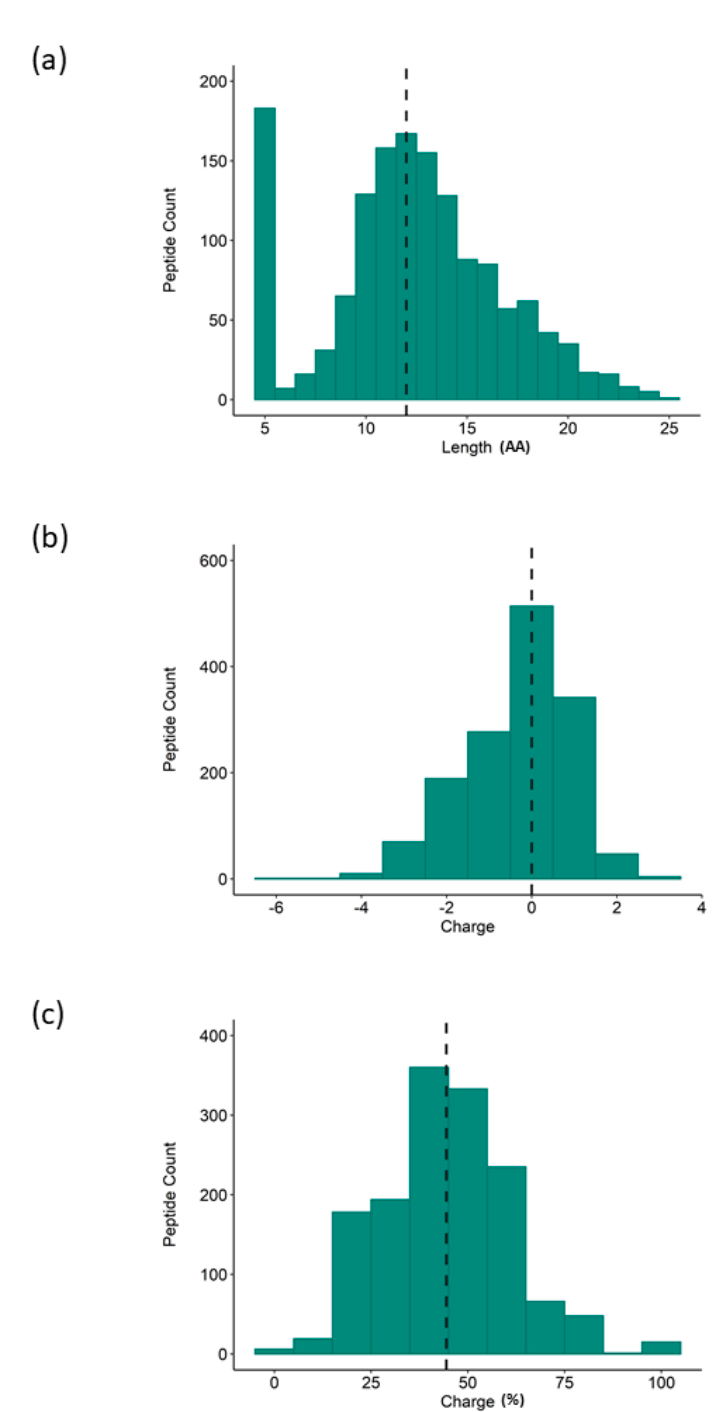
Figure 2. Physicochemical properties of rice NPN peptide profile as determined by LC-MS/MS. Histogram representation of rice NPN peptide distribution according to ( a ) length of peptide sequence, ( b ) charge of constituent peptides, and ( c ) percentage of hydrophobic residues (Hydrophobicity; peptide counts are displayed on the y axis; dashed line represents the median.